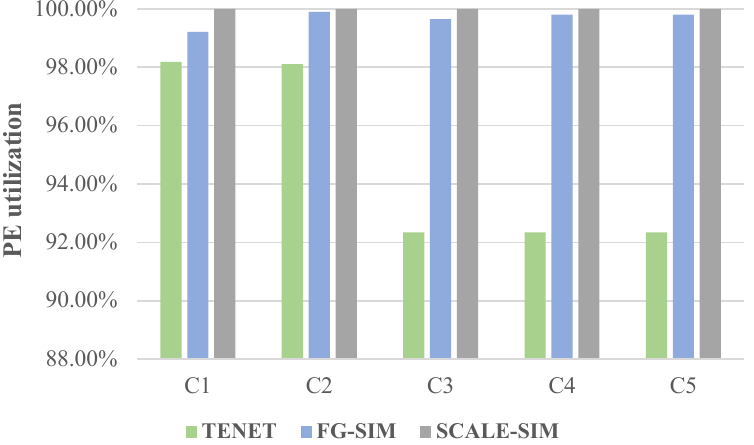
Figure 13. PE utilization comparison with TENET and Scale-sim on AlexNet, C1–C5 means CONV1, CONV2, ...,